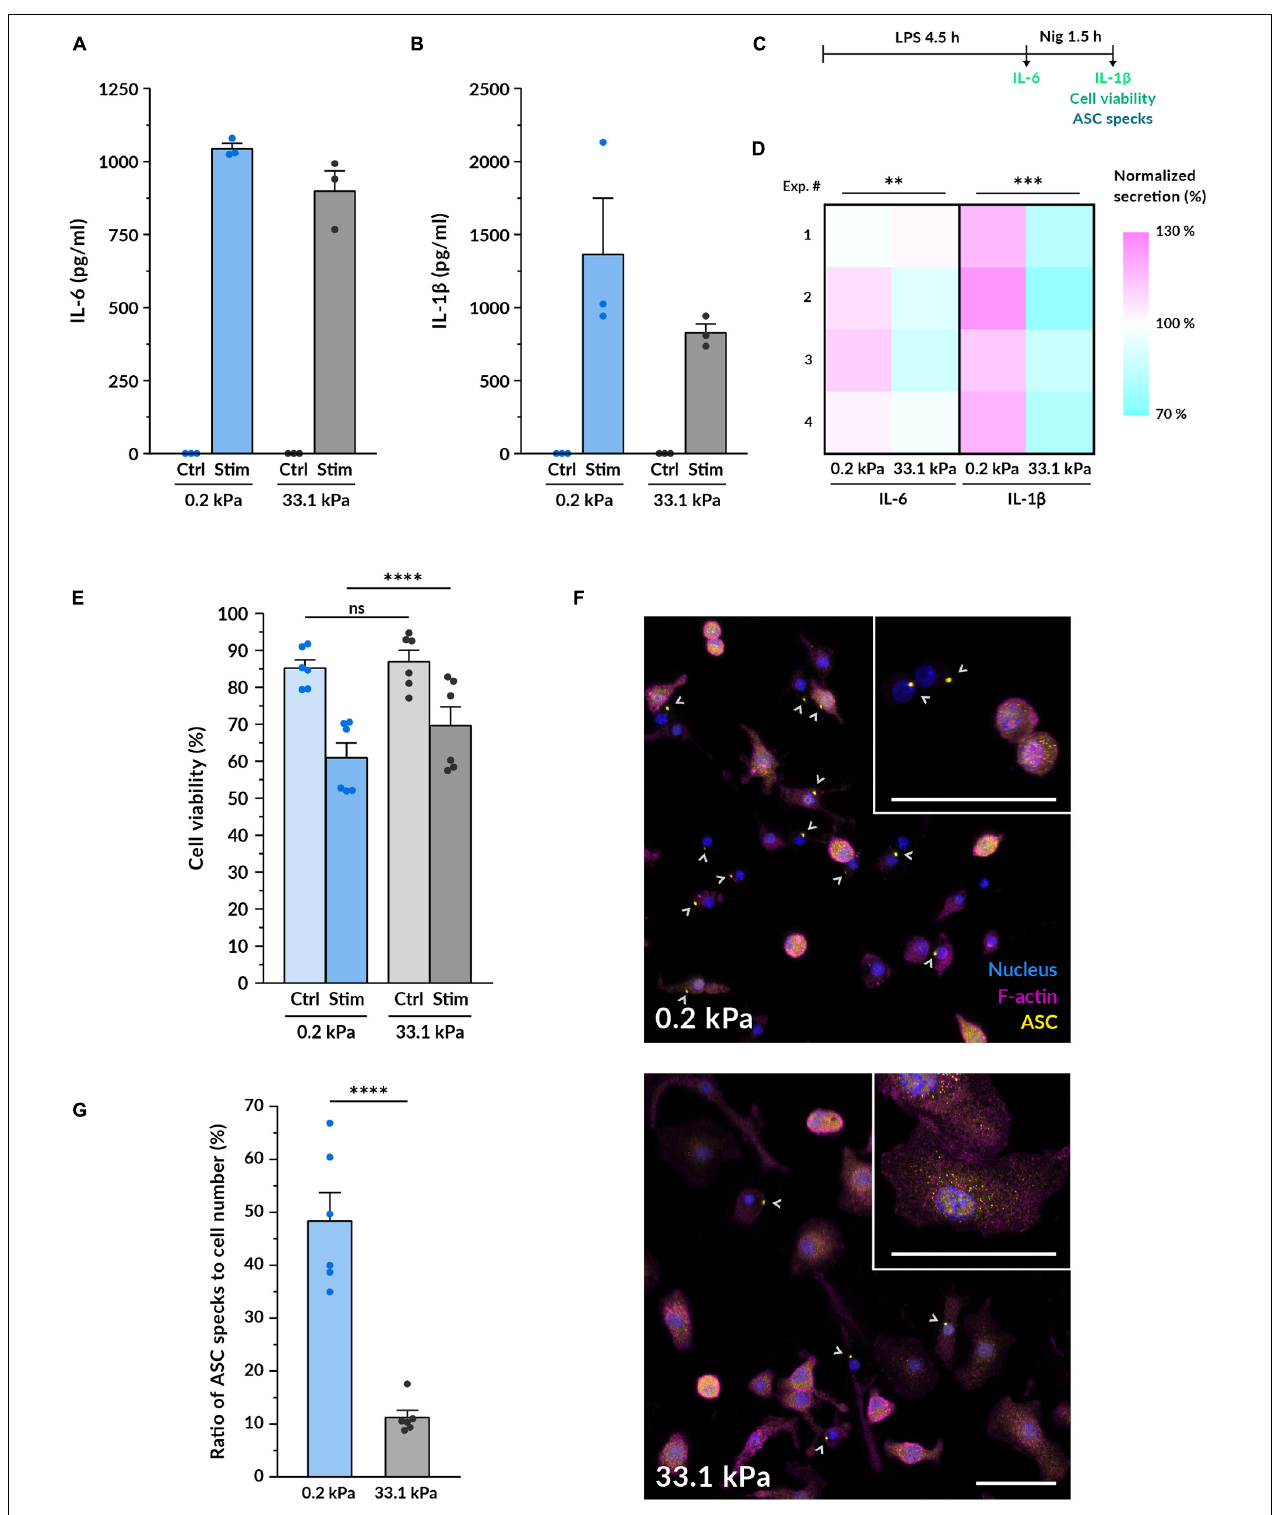
FIGURE 3 | Macrophage pro-inflammatory response is upregulated by more compliant substrates. (A,B) Quantification of the protein levels of the cytokines IL-6 (A) and IL-1 β (B) secreted by macrophages on compliant and stiff polyacrylamide hydrogels via ELISA. BMDMs were cultured for 14–18 h on the hydrogels, primed with 100 ng/ml LPS for 4.5 h and stimulated with 10 µ M nigericin for 1.5 h. IL-6 supernatants were collected after LPS priming, for IL-1 β after nigericin treatment. Results